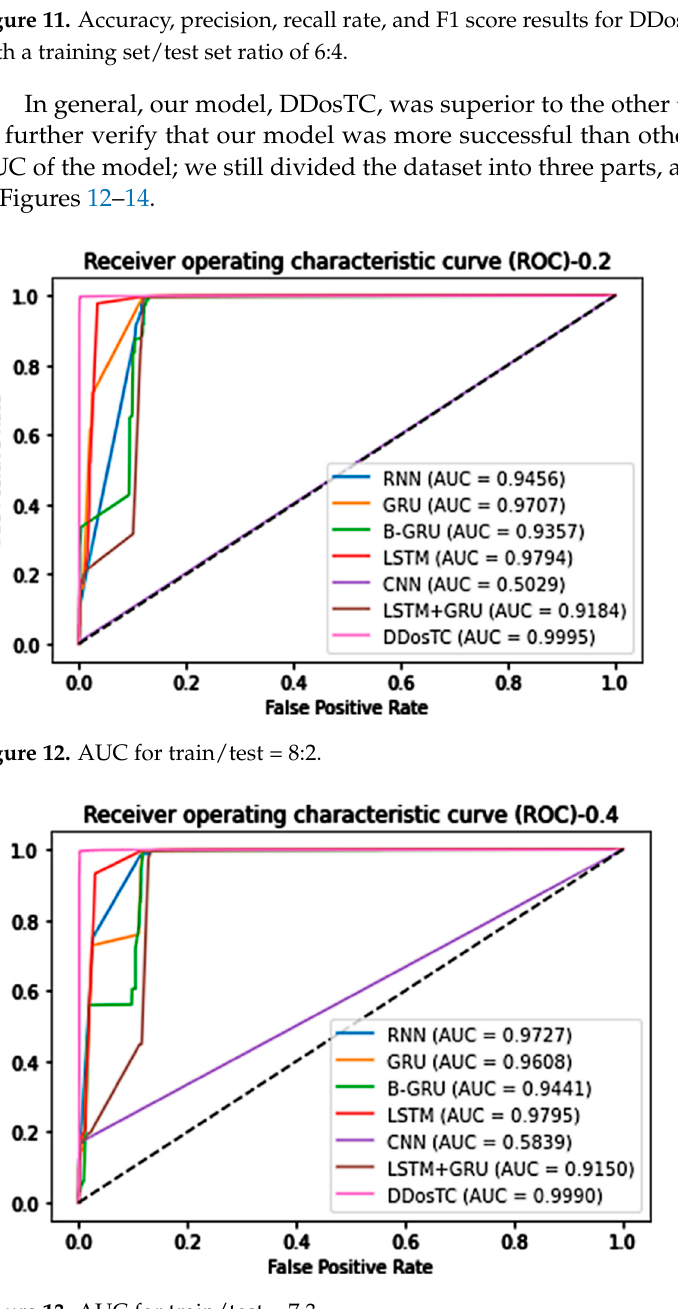
Figure 11. Accuracy, precision, recall rate, and F1 score results for DDosTC and other test methods with a training set/test set ratio of 6:4.